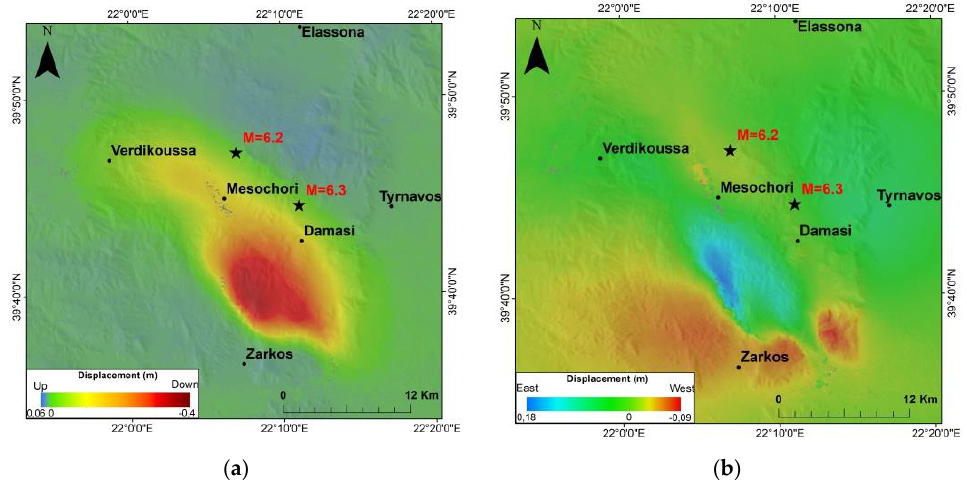
Figure 16. Displacements in ( a ) vertical and ( b ) east–west directions for both the 3 and 4 March 2021 earthquakes. Stars and magnitudes as in Figure 15.